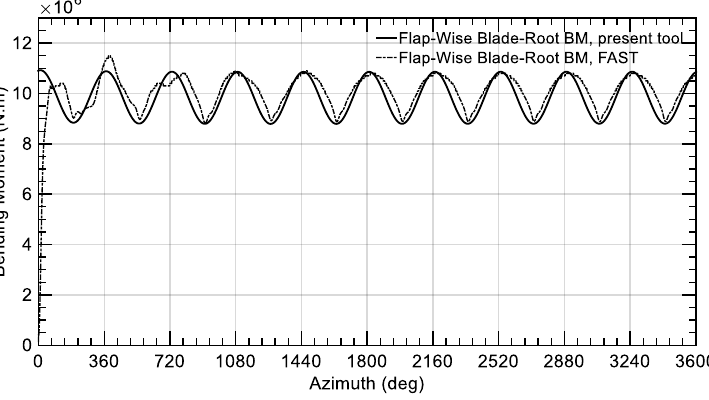
Figure 10. Blade-root, flap-wise bending moment.